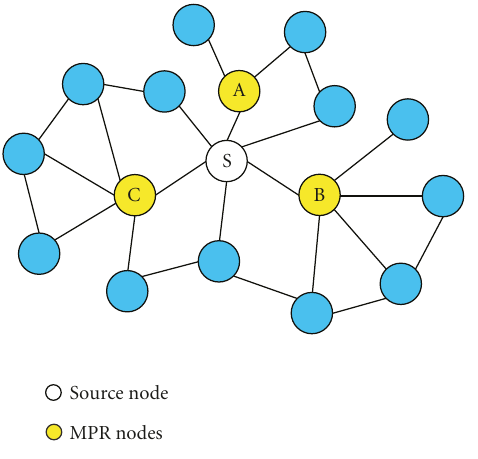
Figure 2: OLSR Multipoint Relays selection.